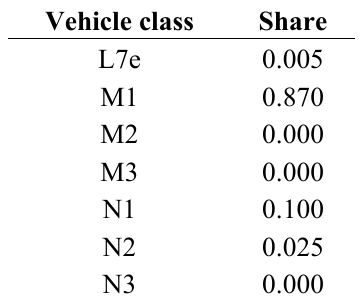
Table 8. EV classes definition.